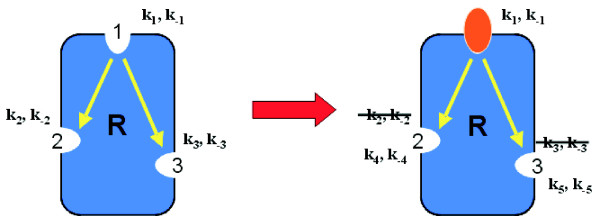
Domain interactions. We assume that binding domain one controls the other two domains like indicated by the arrows. From this assumption the kinetic parameters for the model follow immediately. As soon as binding domain one is occupied, the affinities of the docking sites two and three will change. Since binding domain one is independent of the other binding sites, the on- and off-rate constants of this domain are also independent.